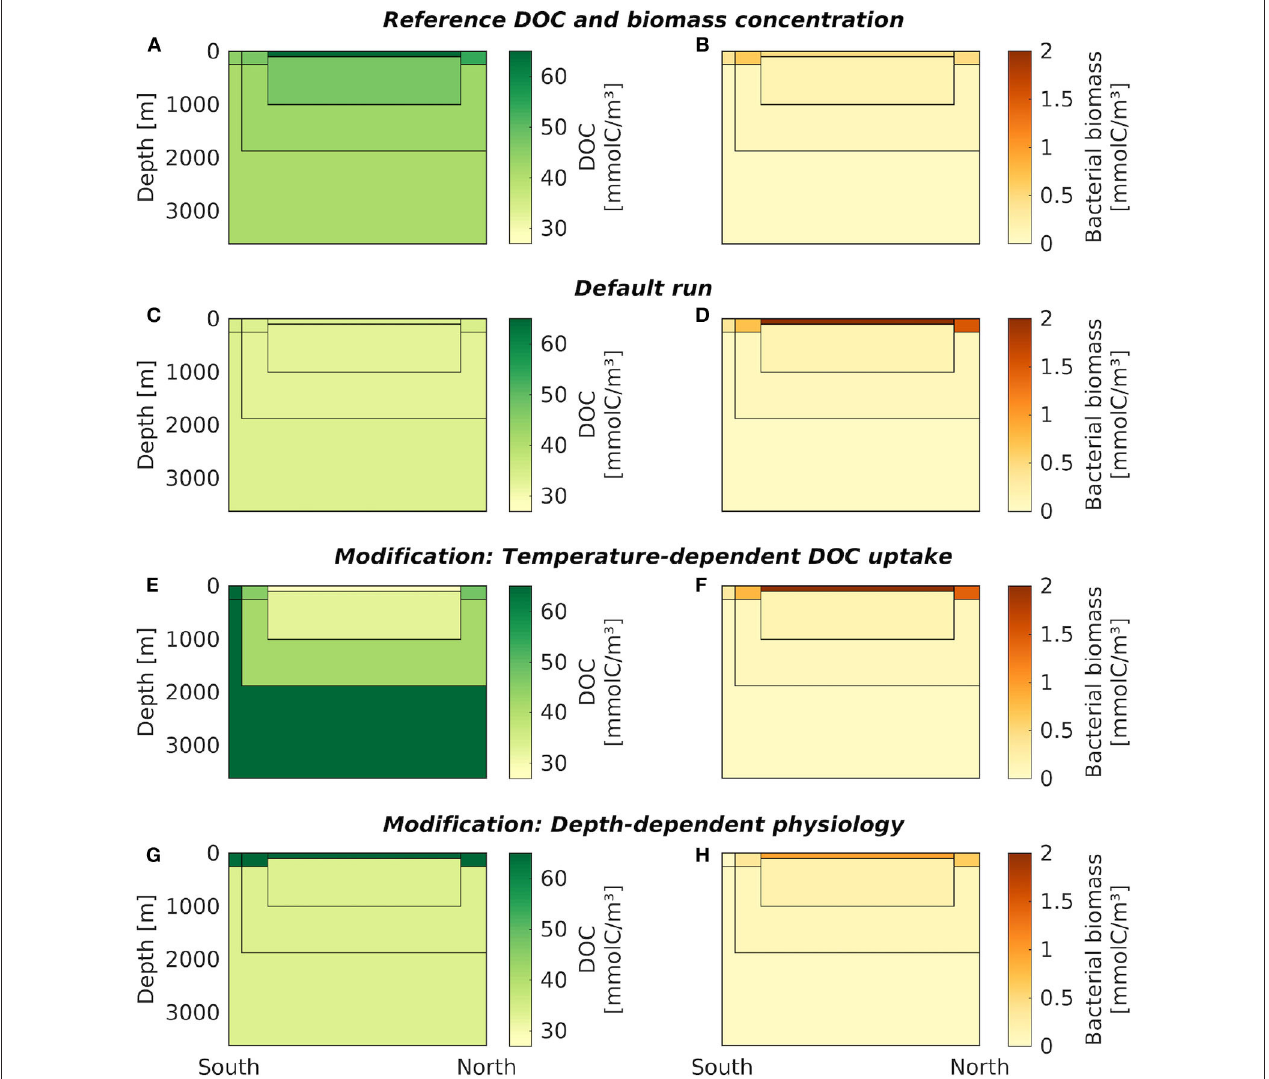
FIGURE 3 | Carbon concentrations from the default box model and its modifications. DOC (left column) and microbial biomass (right column) concentrations are shown in the seven oceanic boxes, for: (A,B) the reference data, (C,D) the default box model run, (E,F) a model modification with temperature-dependent DOC uptake, and (G,H) a model modification with depth-dependent physiological parameters. For exact DOC concentrations at the end of each simulation, see Table 3 , and Supplementary Table 4 for microbial biomass, respectively. The results of the model modification with seasonal supply are shown over time in Figure 4 ; averaged over one year they closely match the default model run shown in (A,B)